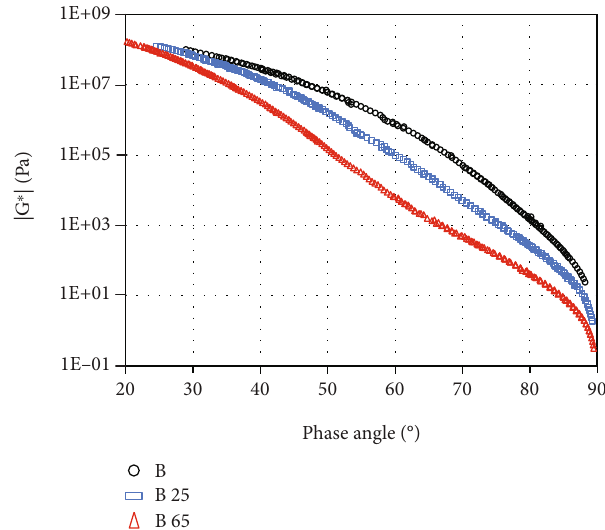
Figure 1: Black diagrams for the unmodi fi ed binder at di ff erent levels of